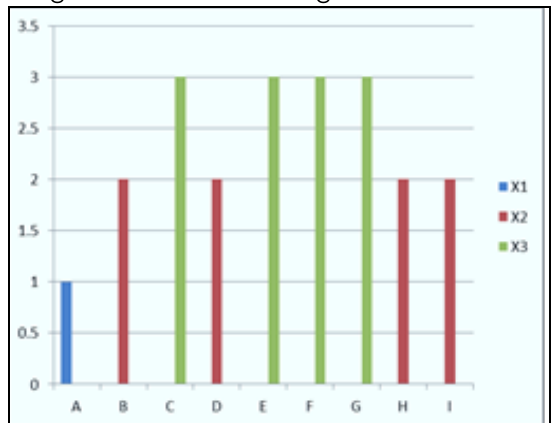
Figure 5. Residents’ Interaction and duration in Ijebu-jesa market place. A =Hausa & Igbo, B =Hausa & Yoruba, C =Hausa & Hausa, D =Yoruba & Igbo, E =Yoruba & Hausa, F =Yoruba & Yoruba, G =Igbo & Hausa, H =Igbo & Yoruba, I =Igbo & Igbo. ×1= Less than 15 minutes (short interaction), ×2= between 15 to 20 minutes (medium interaction), ×3= between 20 to 30 minutes (long interaction)